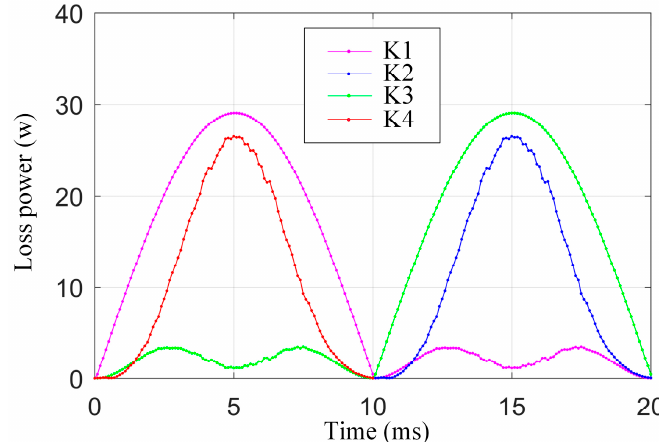
Figure 13. Electromagnetic loss in the PWM rectifier.